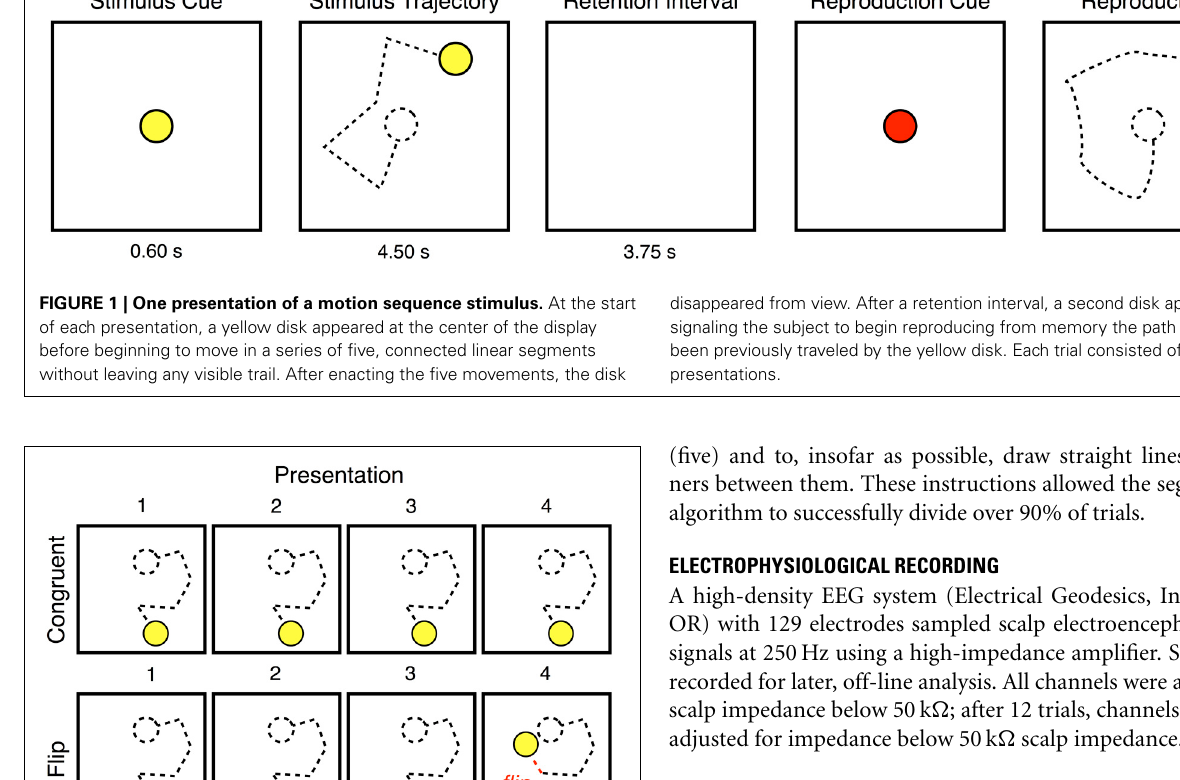
FIGURE 2 | The sequence of presentations that made up a Congruent trial or Flip trial. In our analyses, we considered the first presentation of a stimulus to be new , the fourth presentation of a Congruent trial to be familiar , and the “flipped” segment at the end of a Flip trial to be deviant